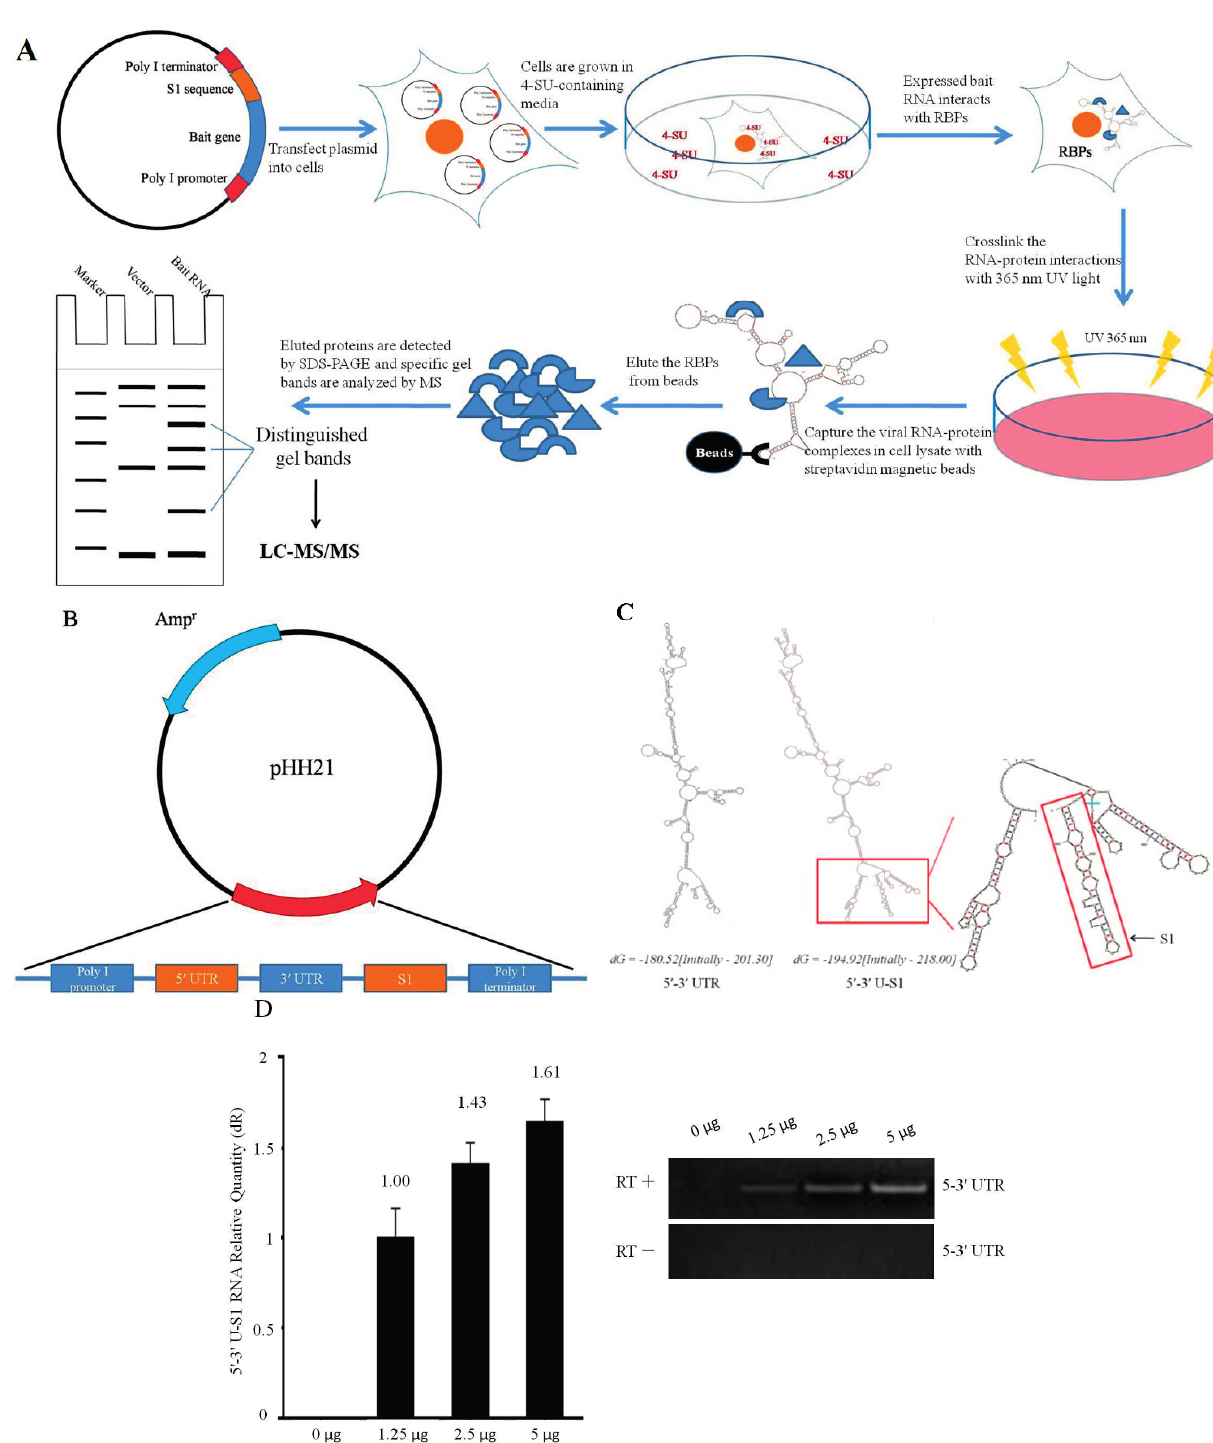
Figure 1. ( A ) Schematic of experimental strategy to purify S1 aptamer-tagged vRNAs and endogenously-assembled RNA-protein complexes under non-denaturing conditions; ( B ) Cloning strategy for plasmid to express aptamer-tagged viral RNAs. The 3 ′ end of DENV 5 ′ –3 ′ UTR RNA was tagged with S1 aptamer (that binds streptavidin) and subcloned into the pHH21 vector backbone between the RNA polymerase I promoter and polymerase I terminator; ( C ) The secondary structures of DENV 5 ′ –3 ′ UTR and 5 ′ –3 ′ U-S1 sequence were predicted by RNAfold. Red boxes show the region where the S1 sequence is cloned in